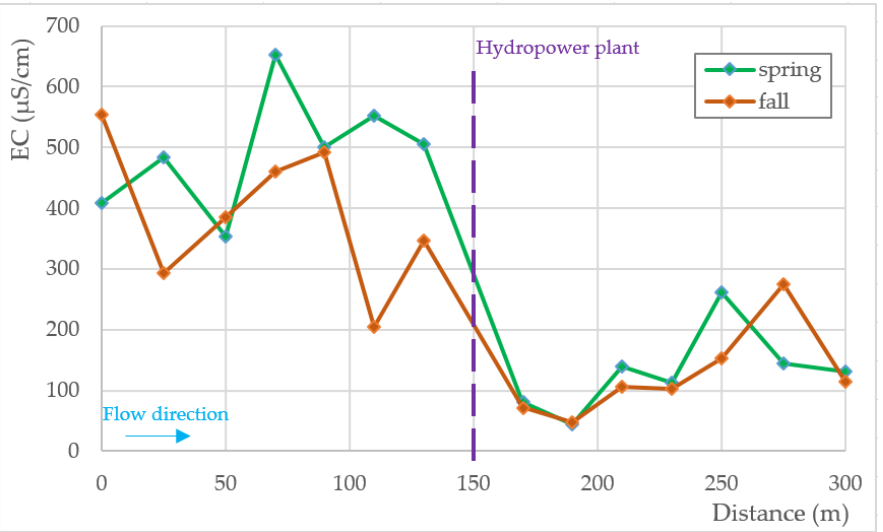
Figure 13. Changes in conductivity values in sediments in spring and fall near the hydropower plant on the Ślęza River, along with the geochemical classification.